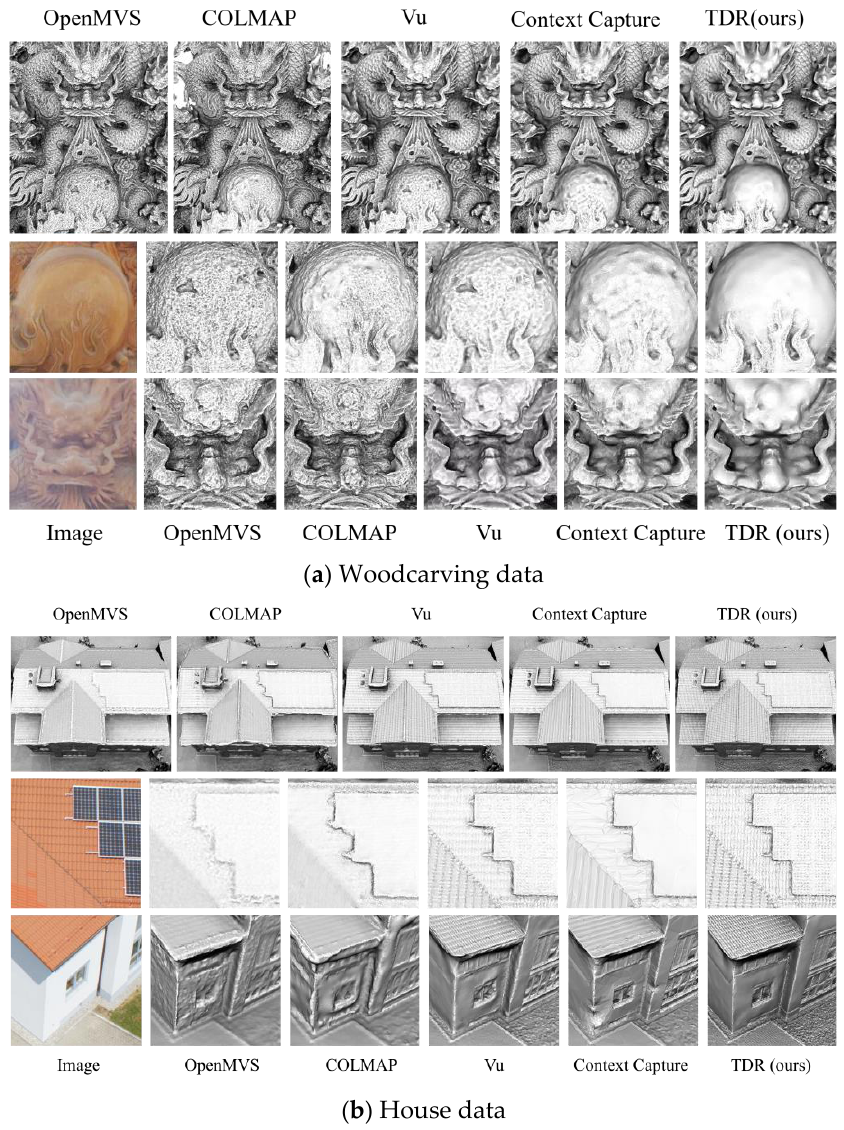
Figure 14. Visual comparison on the Personal Collection Dataset.